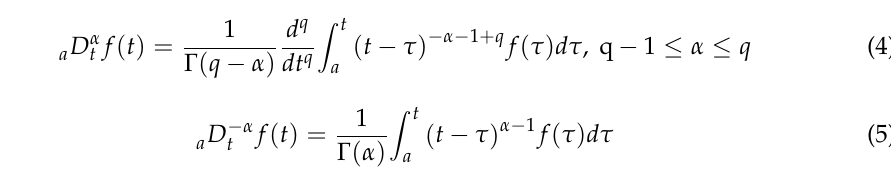
tives in Equations (4) and (5).